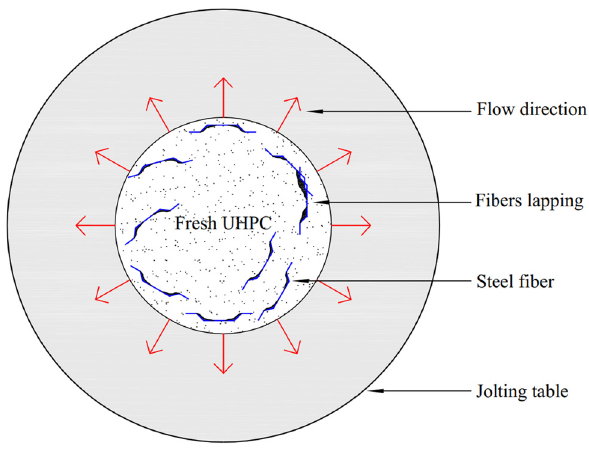
Figure 7: Flow diagram of fresh UHPC with steel fi bres on a jolting table.